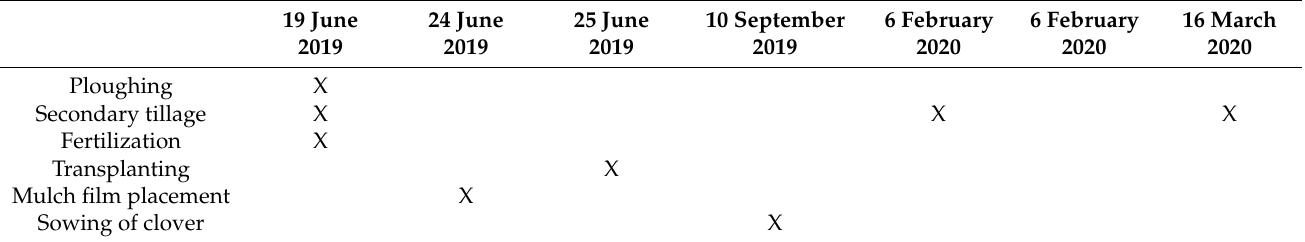
Table 1. List of the operations carried on and dates of